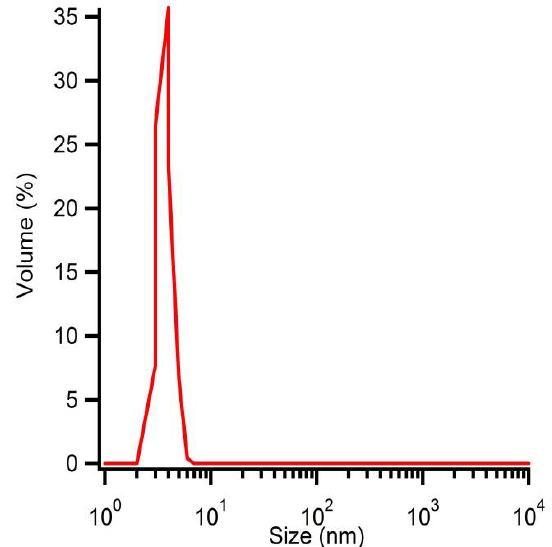
Figure 8. Hydrodynamic radius of solution B microwave treated at 180 °C for 10 min determined by DLS measurement s represented as a function of volume